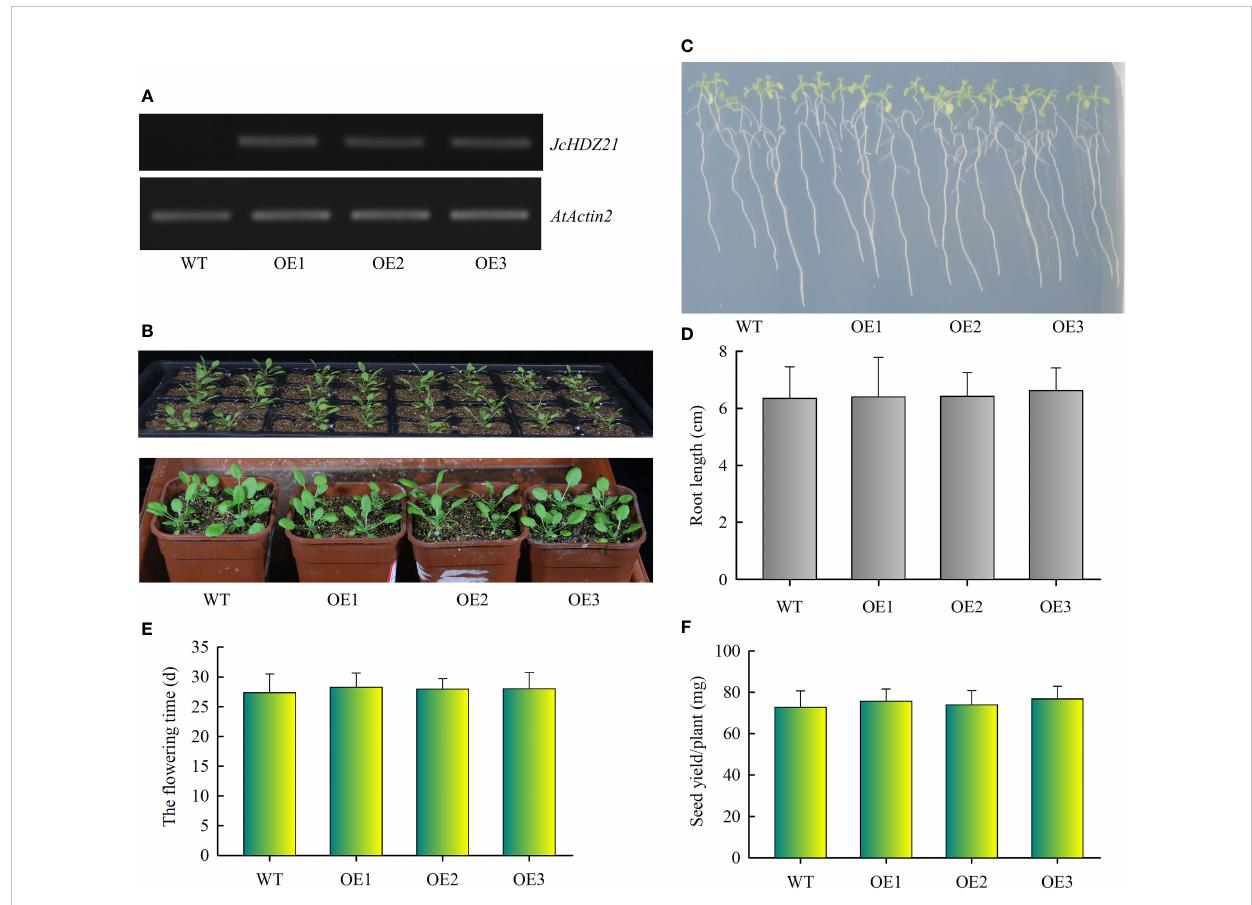
FIGURE 5 Phenotype of JcHDZ21 transgenic Arabidopsis plants under normal growth condition. (A) Expression levels of JcHDZ21 in wild-type and transgenic plants. (B) Growth status of wild-type and JcHDZ21 transgenic plants at 25 days. (C) Root morphology of wild-type and JcHDZ21 transgenic plants at day 10. The seeds of the sterilized wild-type and JcHDZ21 transgenic plants were sown on 1/2 MS medium for vertical cultivation for 4 days, and the plants with consistent growth were selected and transferred to 1/2 MS medium for vertical growth for 6 days. (D) Root length of wild-type and JcHDZ21 transgenic plants at day 10. Data in (D) : means of n = 20 ± SD from three independent experiments. (E) The fl owering time of wild-type and JcHDZ21 transgenic plants. (F) Seed yield of wild-type and JcHDZ21 transgenic plants under normal growth conditions. Values represent means of n = 30 ± SD from three independent